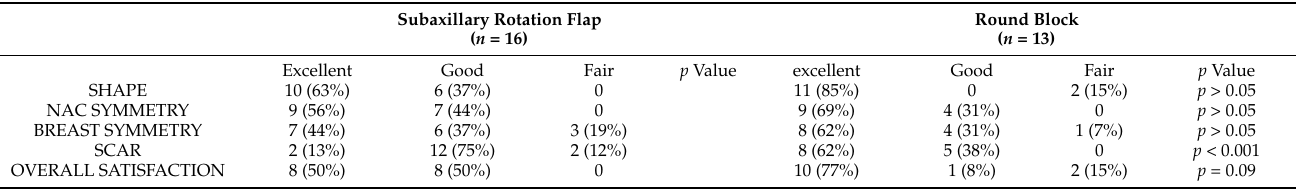
Table 4. Aesthetic results—surgeon’s assessment.